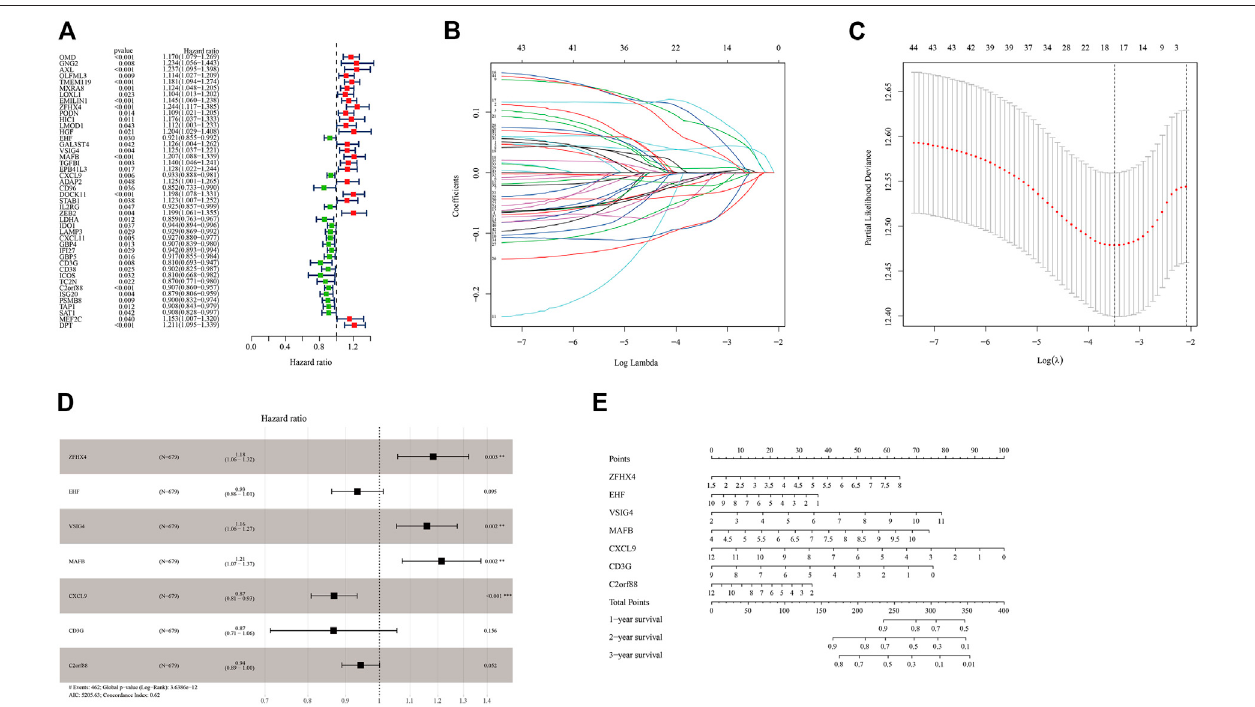
FIGURE 6 | Construction of the prognostic model of immune-related genes. (A) Uni-cox variance analysis of ICI feature gene set. (B,C) Lasso regression analysis results for genes obtained from uni-cox analysis. (D) Multi-cox analysis results of genes obtained from lasso regression analysis. (E) The nomogram of the prognostic model.